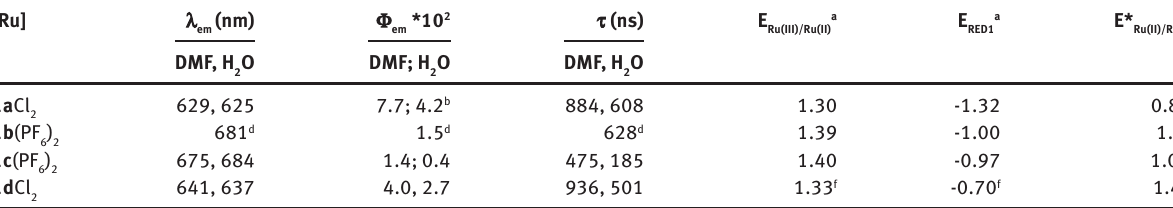
Table 1 Photophysical and electrochemical properties of complexes 1a – 1d